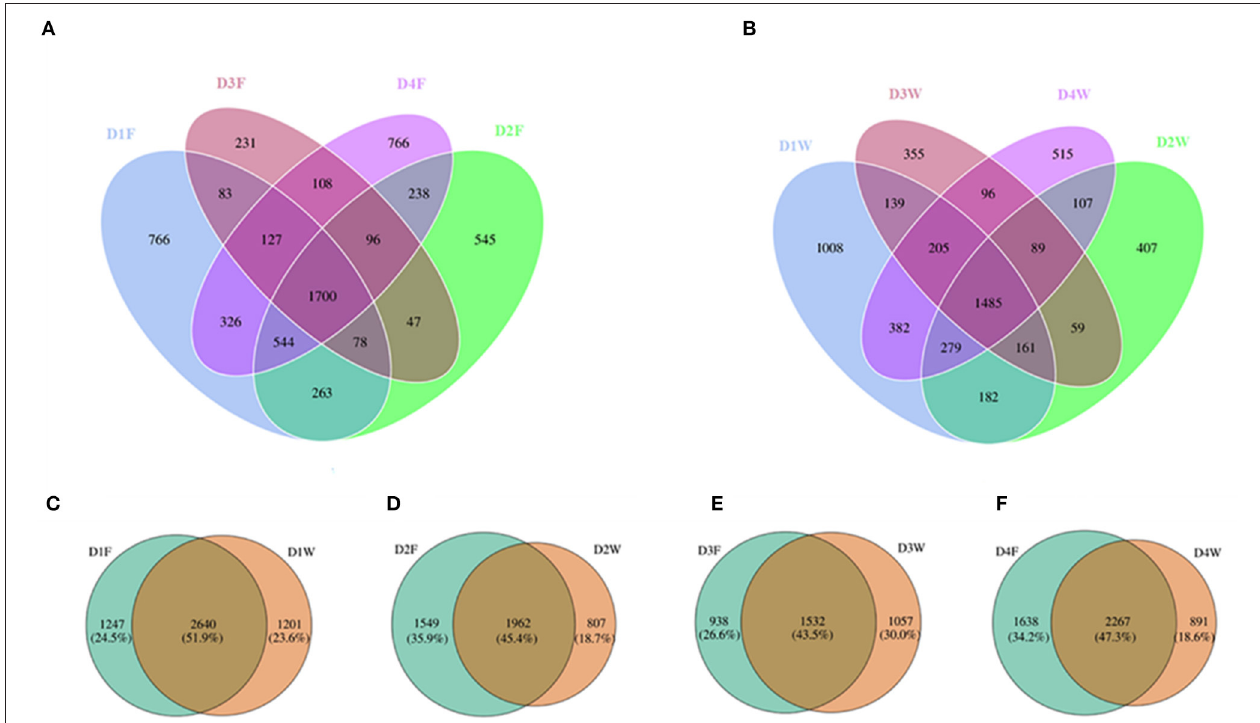
FIGURE 2 | Venn diagram showing the unique and shared operational taxonomic units (OTUs) among different decay classes from (A) fruiting body, (B) dead wood, between fruiting body and dead wood from decay classes 1 (C) , 2 (D) , 3 (E) , and 4 (F) .